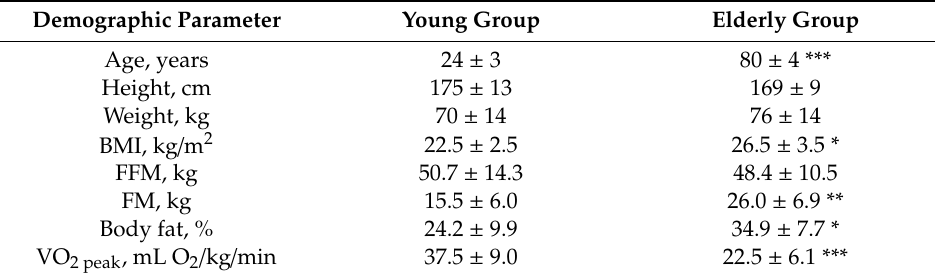
Table 1. General demographic